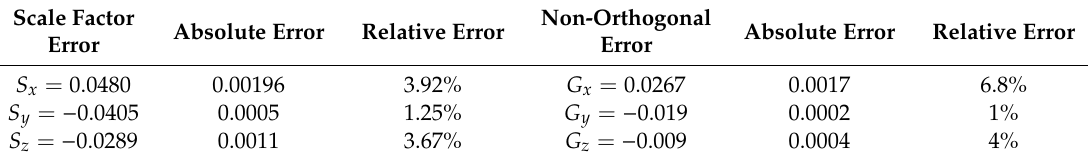
Table 9. Sensor Error Calibration Result.